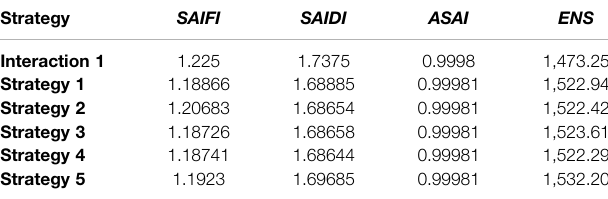
TABLE 7 | The reliability